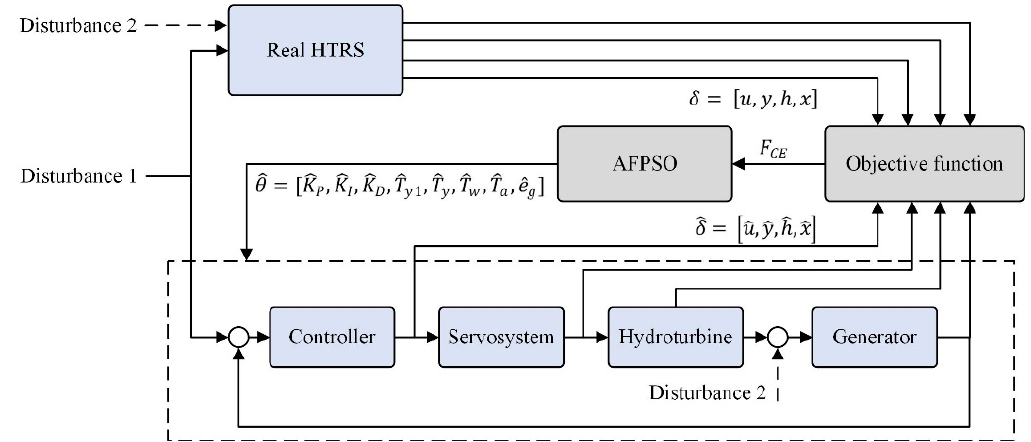
Figure 7. Parameter estimation strategy of hydro-turbine regulation system (HTRS) based on AFPSO.